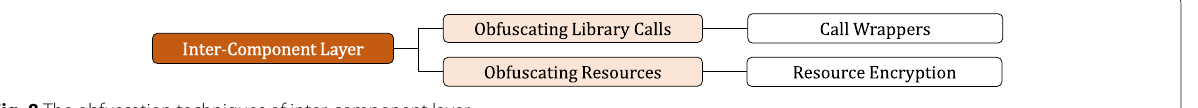
Fig. 8 The obfuscation techniques of inter-component